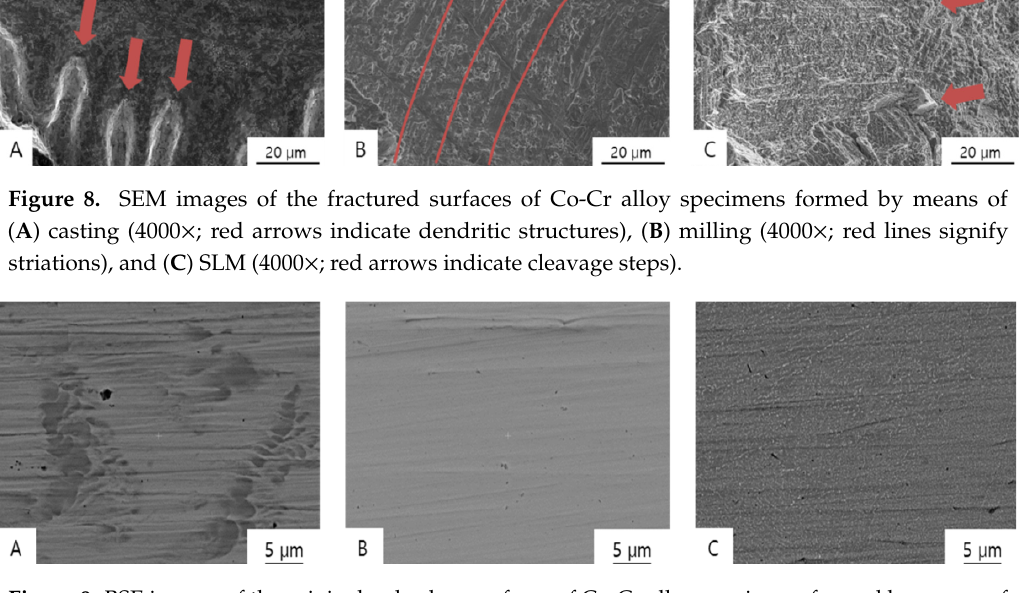
Figure 9. BSE images of the original unbroken surfaces of Co-Cr alloy specimens formed by means of ( A ) casting (10,000 × ; the dark shaded areas indicate dendritic crystal structures), ( B ) milling (10,000 × ; a uniform surface can be observed), and ( C ) SLM (10,000 × ; small crystalline structures that look similar to white grains can be observed).